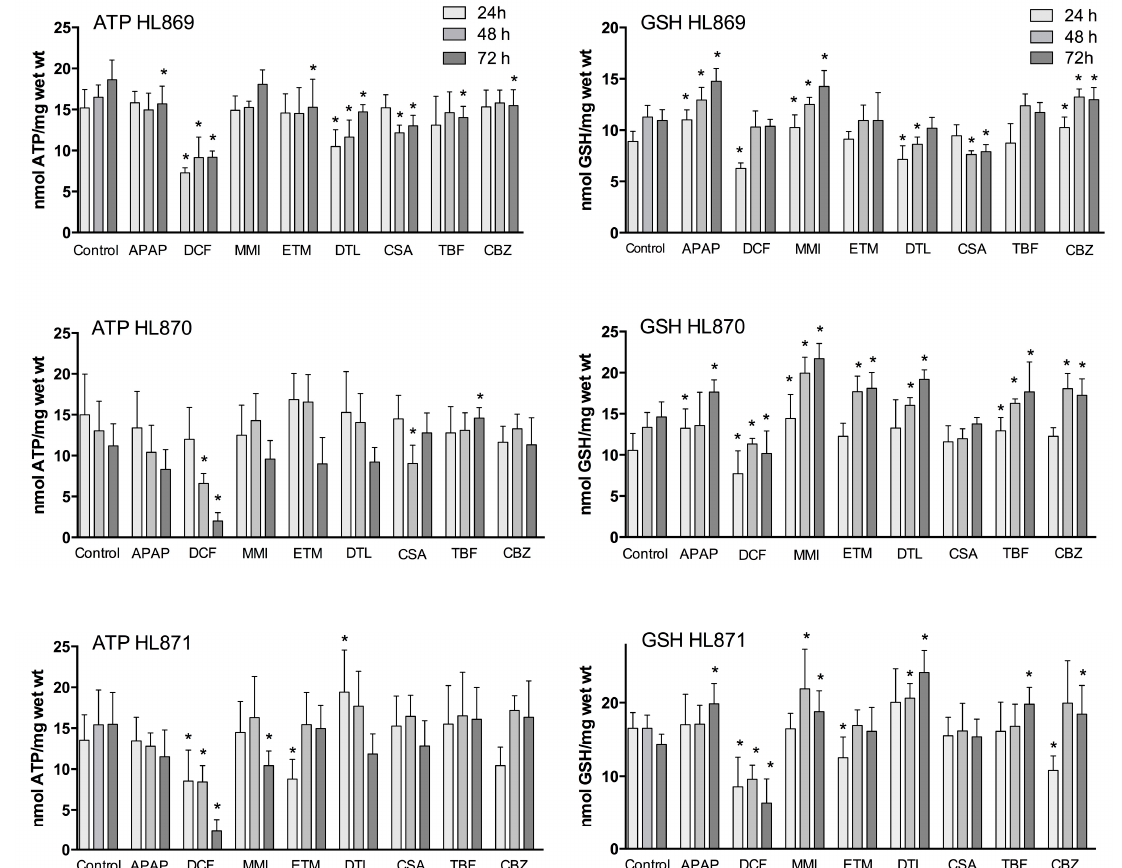
Table 1. Human donor information and markers of human liver slice viability (K + , ATP and GSH levels) in control slices (24–72 h) to verify the quality of the tissue for the duration of the experiment.